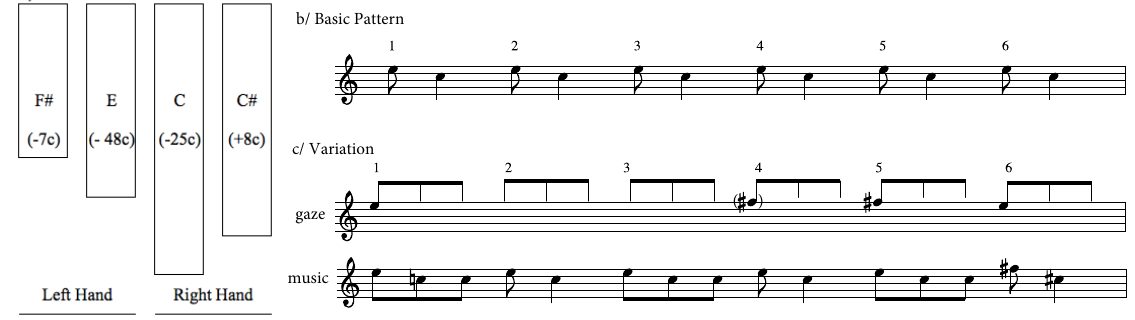
Figure 19. a) top-view representation of the 4 bars of the xylophone played by the Bedzan xylophonist, with their pitch and deviation in cents from equal temperament (a cent is a hundredth of a semi-tone); b) transcription of the basic pattern; c) transcription of a vari- ation of the musical pattern (bottom line), with the musical score of the gaze superimposed (top line). Numbers 1 to 6 refer to the beats of the musical